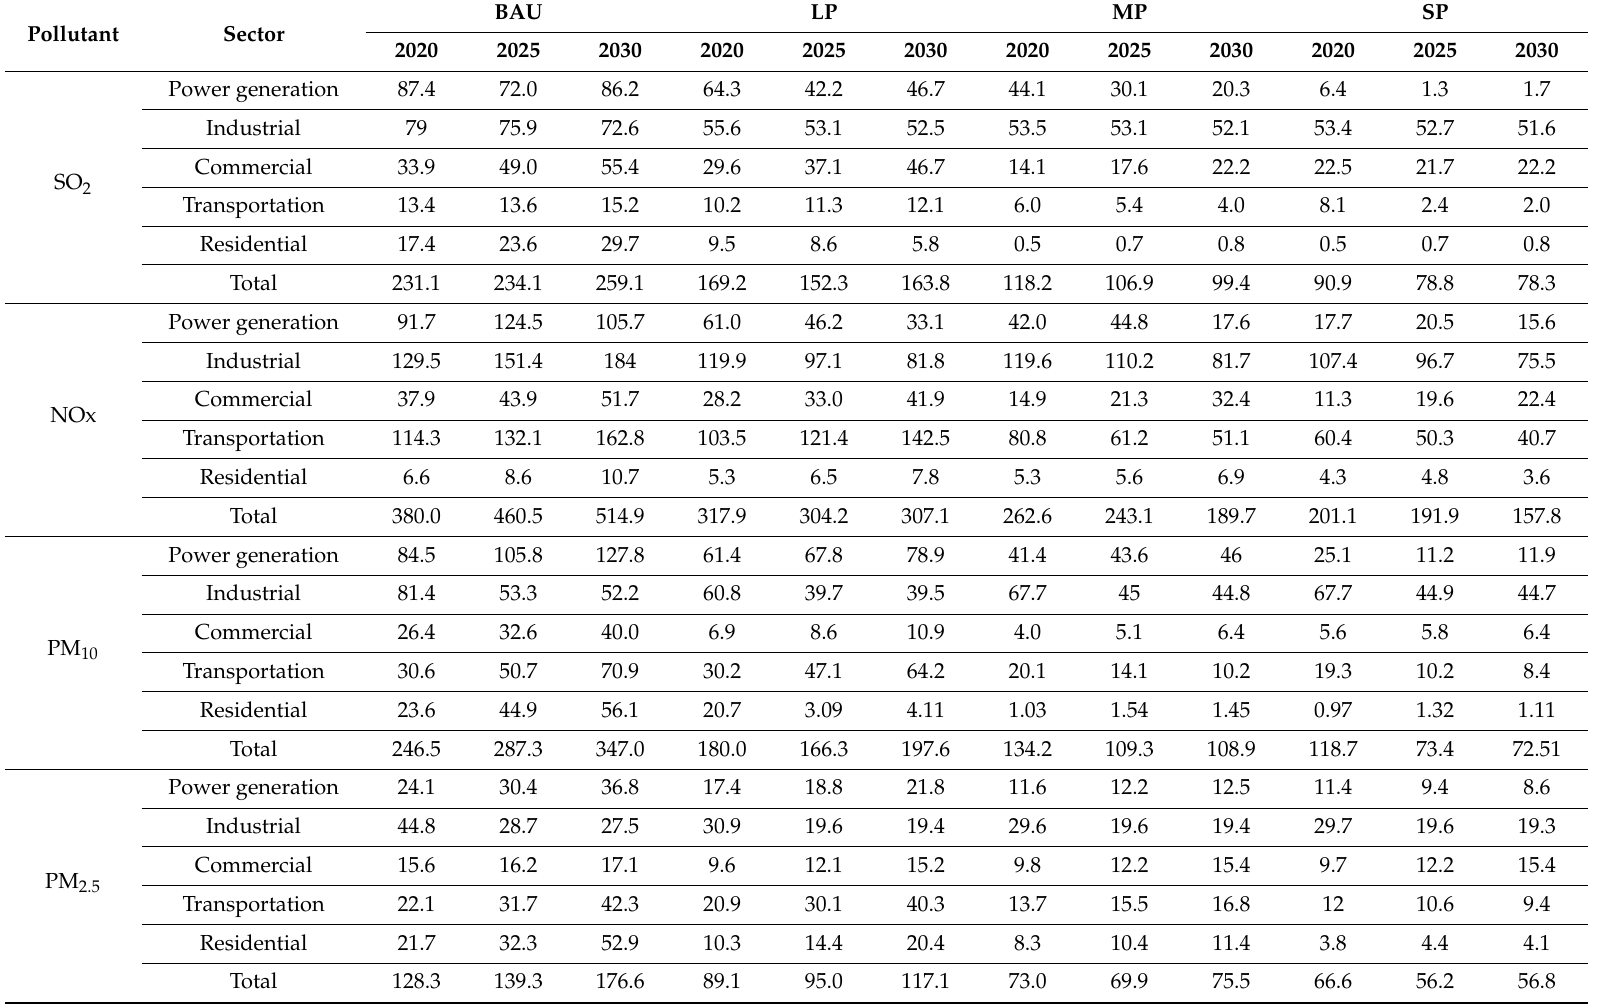
Table 6. Local air pollutants (LAPs) emissions under di ff erent scenarios for di ff erent sectors (unit: